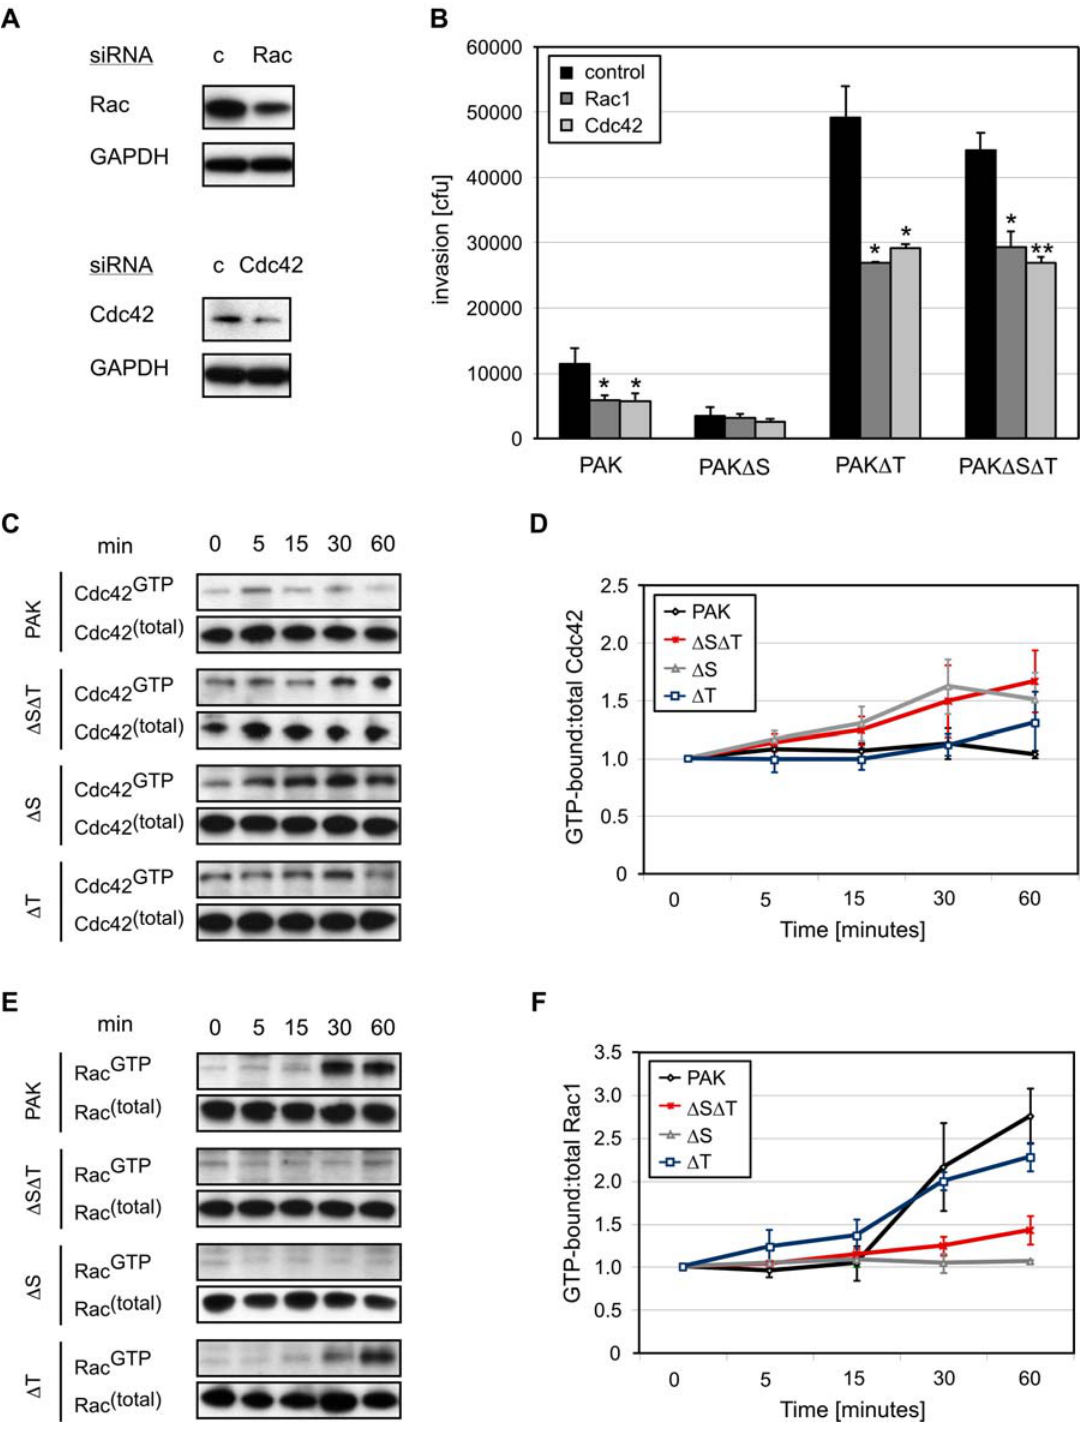
Figure 4. Rac1 and Cdc42 are required for invasion of P.aeruginosa into mammalian cells. (A) HeLa cells were treated with Rac1, Cdc42 or control (c) siRNA. Cell lysates were immunoblotted with anti-Rac1 and anti-Cdc42, respectively. GAPDH was used as loading control. (B) Internalization of PAK, PAK D S, PAK D T and PAK D S D T at 1 h was quantified in HeLa cells treated with control siRNA or siRNA against Rac1 or Cdc42. *p , 0.05, **p , 0.01 compared to control RNA-treated cells for each bacterial strain. (C–F) GTPase activation assays. HeLa cells were infected with PAK, PAK D S D T, PAK D S and PAK D T for the indicated times. Lysates were incubated with Pak1-PBD to precipitate GTP-bound Cdc42 and GTP-bound Rac1. The bound proteins and cell lysates were examined by immunoblotting with anti-Cdc42 (C) and anti-Rac1 (E) , respectively. The experiments were performed 3 times and a typical gel is shown. (D, F) The GTPases activation assays to assess Cdc42 (D) or Rac1 (F) activation upon infection with PAK, PAK D S D T, PAK D S and PAK D T were quantified by densitometry. Shown are the mean values + /- SD from three independent experiments.